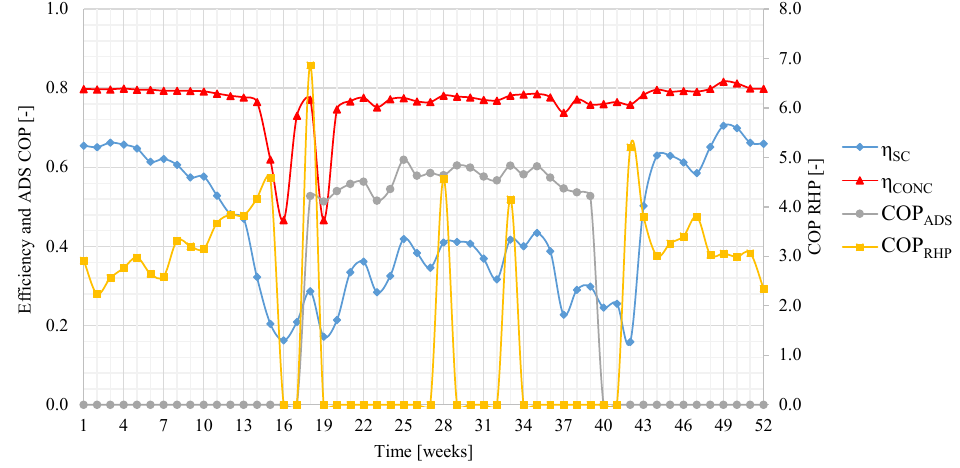
Figure 11. Thermal efficiency of SC and CONC and the COP of ADS and RHP, weekly analysis. SC field achieves a relatively better thermal performance during the winter with re- spect to summer and mid-season weeks, and this is due to the lower operation temperature of HW. In fact, during such a period the solar collector works with a relatively small temperature, limiting the thermal losses. Therefore, the variation of SC efficiency is significant, ranging between 0.159 and 0.705. Conversely, apart from few weeks in the mid-season period, the efficiency of CONC is stable, varying from 0.738 to 0.817. The variation of COP of ADS is relatively small (0.514–0.619), and, as expected, the highest values are achieved for the weeks with higher insolation. This result is due to the implemented control strategy on the ADS generator supply temperature, which is kept in the required range by the supply of heat by TK1 and GB. Furthermore, the COP of RHP during winter oscillates between 2.24 and 4.59, while during the cooling period it ranges from 4.16 and